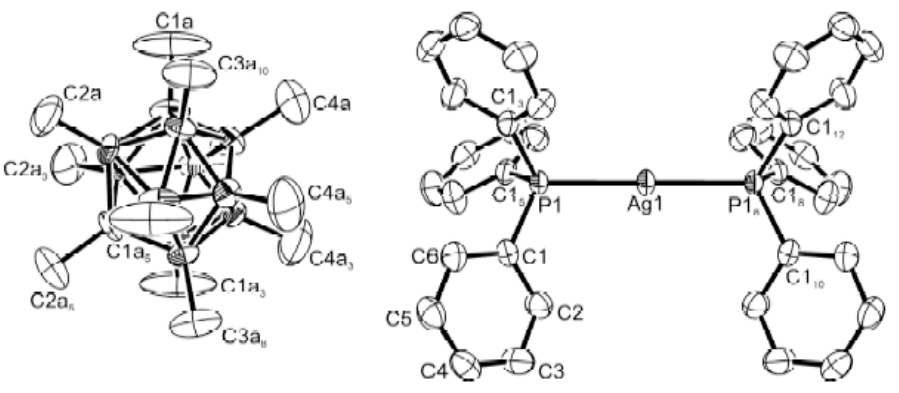
Figure 96. X-ray structure of [(Ph 3 P) 2 Ag][HCB 11 Me 11 ]. Reprinted with permission from reference [104]. Copyright © (2004) American Chemical Society.